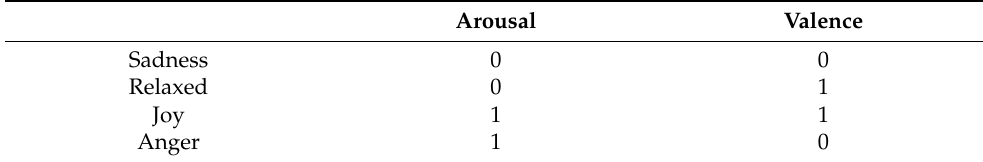
Table 4. Arousal and valence by